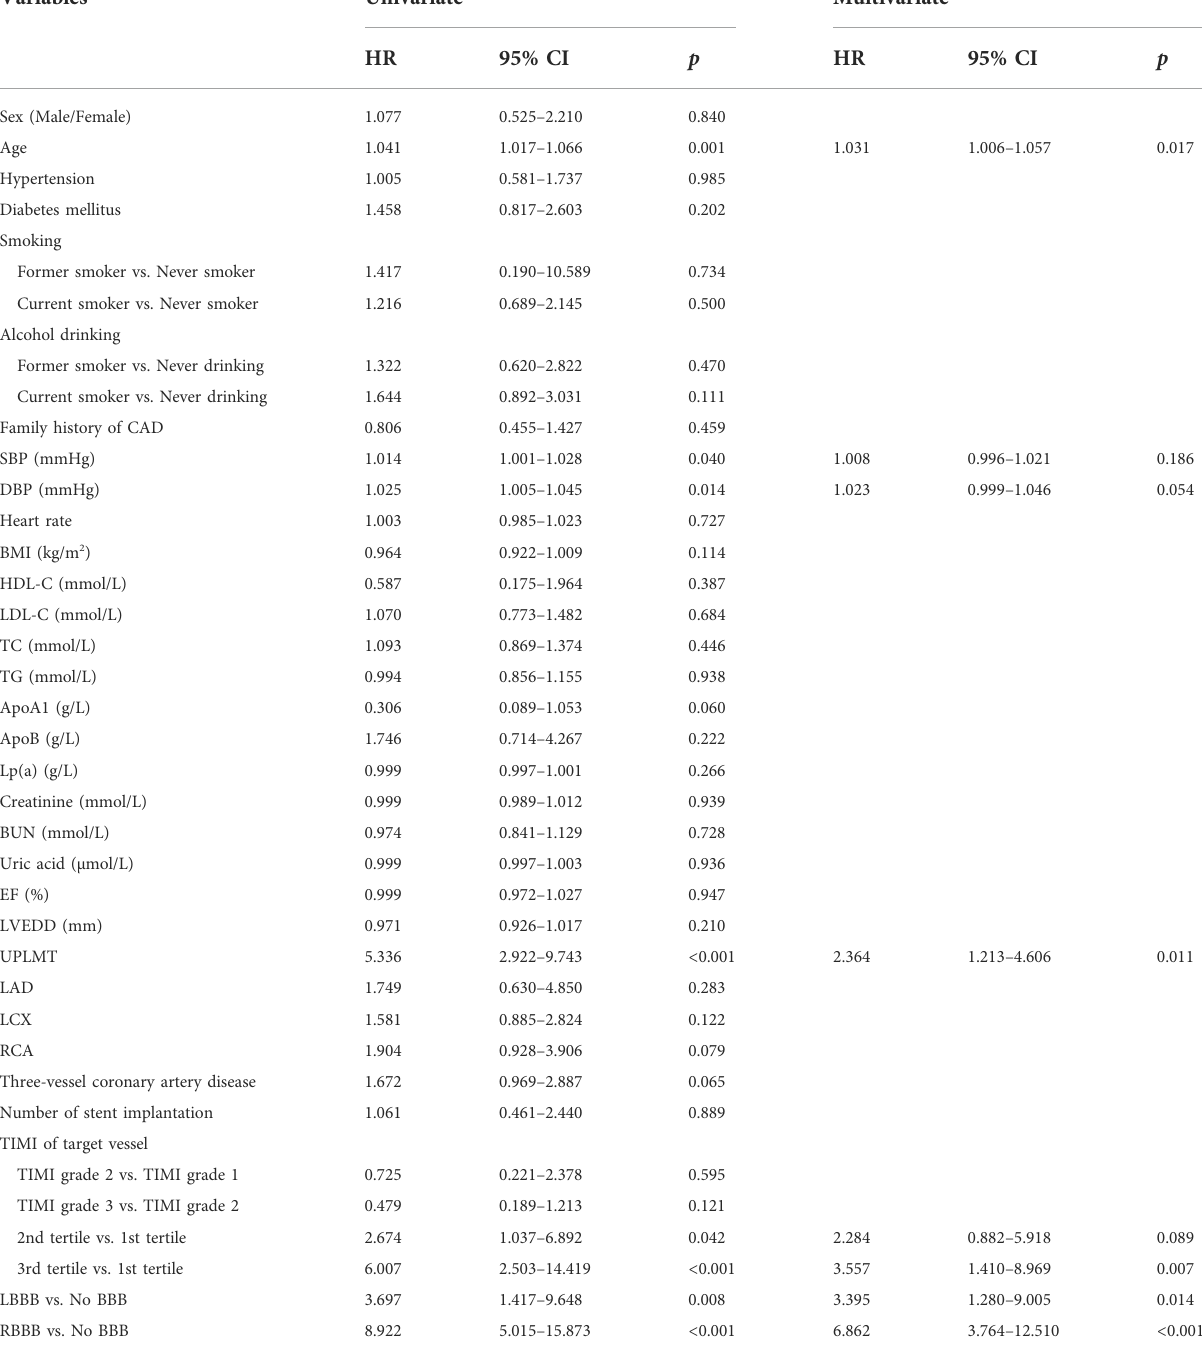
TABLE 5 Potential predictors for the incidence of MACCEs in patients with new onset STEMI who underwent